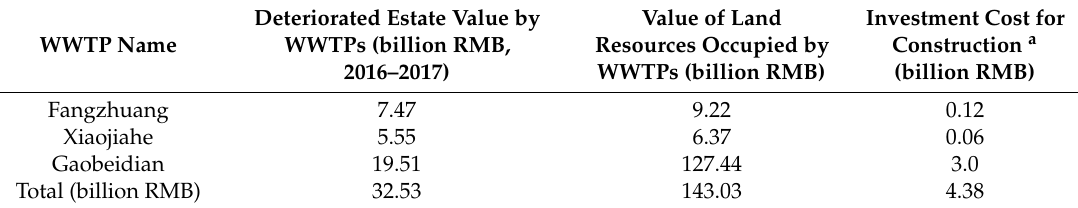
Table 5. Comparison of deteriorated estate value, land price and construction investment for WWTPs in